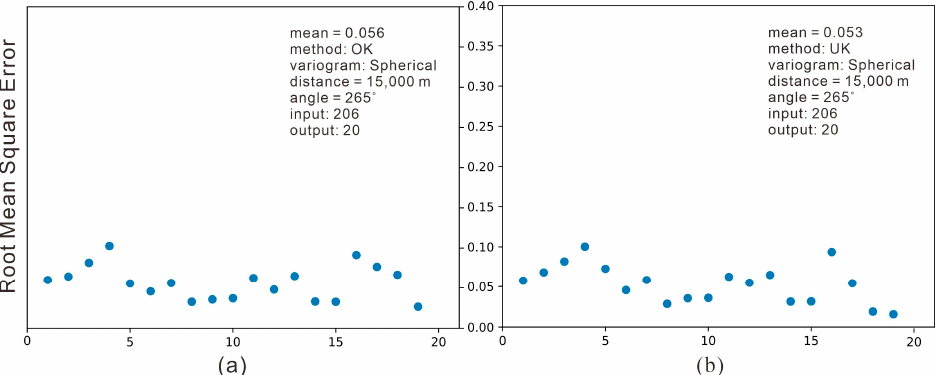
Figure A10. An additional test to compare the RMSE of different methods: ( a ) OK; and ( b ) UK. The mean RMSEs and parameters are listed in the top right-hand corner.